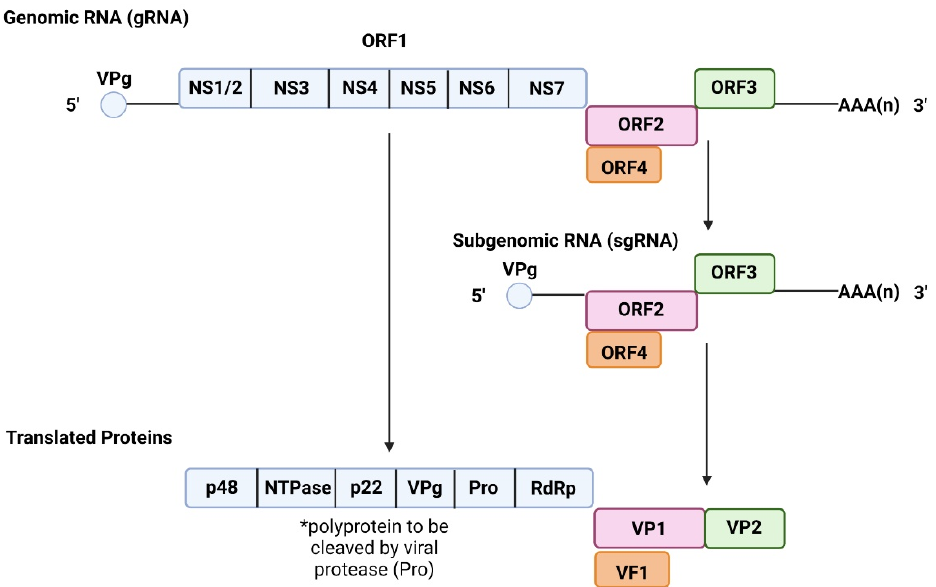
Figure 1. NoV Genome Organisation and Translated Proteins. NoV is divided into ORF1-ORF4, where ORF4 is only present in MNV-1. ORF1 encodes for a structural polyprotein, which when cleaved by viral protease gives rise to 6 non-structural proteins. ORF2 encodes for major capsid protein VP1 and ORF2 encodes for minor capsid protein VP2, which both form the viral capsid. VF1 encoded for by ORF4 in MNV-1 has been shown to assist in enhancing viral infectivity. Made using Biorender.com, accessed on 18 October 2022.